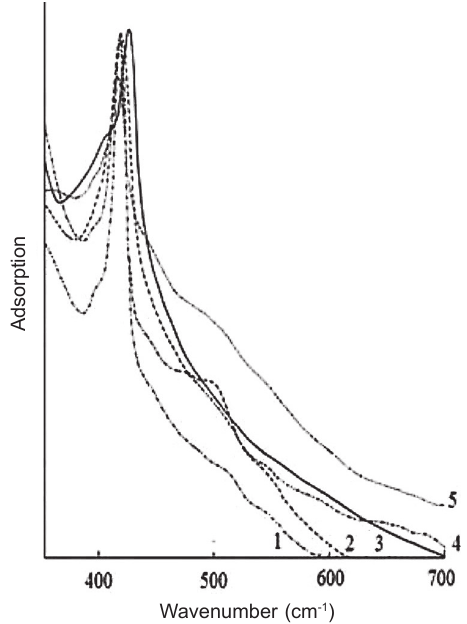
Fig. 4 – Visible absorption spectra of (1) Cd(II) MMT react- ed with pyrrole and cinnamaldehyde, (2) Zn(II) MMT reacted with pyrrole and salicylaldehyde, (3) Ni(II) MMT reacted with pyrrole and phenylacetaldehyde, (4) Fe(III) MMT reacted with pyrrole and l-naphthaldehyde, (5) Co(Il) MMT reacted with pyrrole and 4-carooxybenzaldehyde. The spectra were taken as suspensions in chloroform after 24